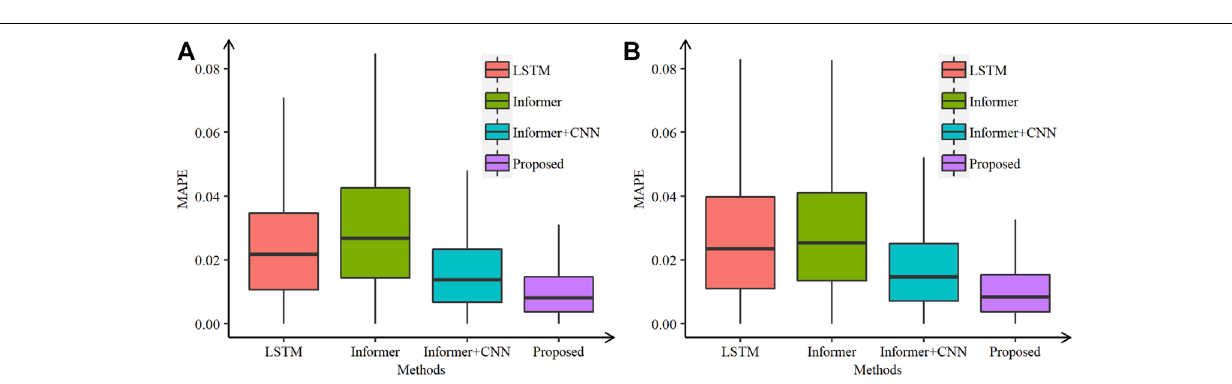
FIGURE 4 | Comparative box plots of the proposed and other models in 2006 of the ISO-NE data set using (A) real and (B) noisy